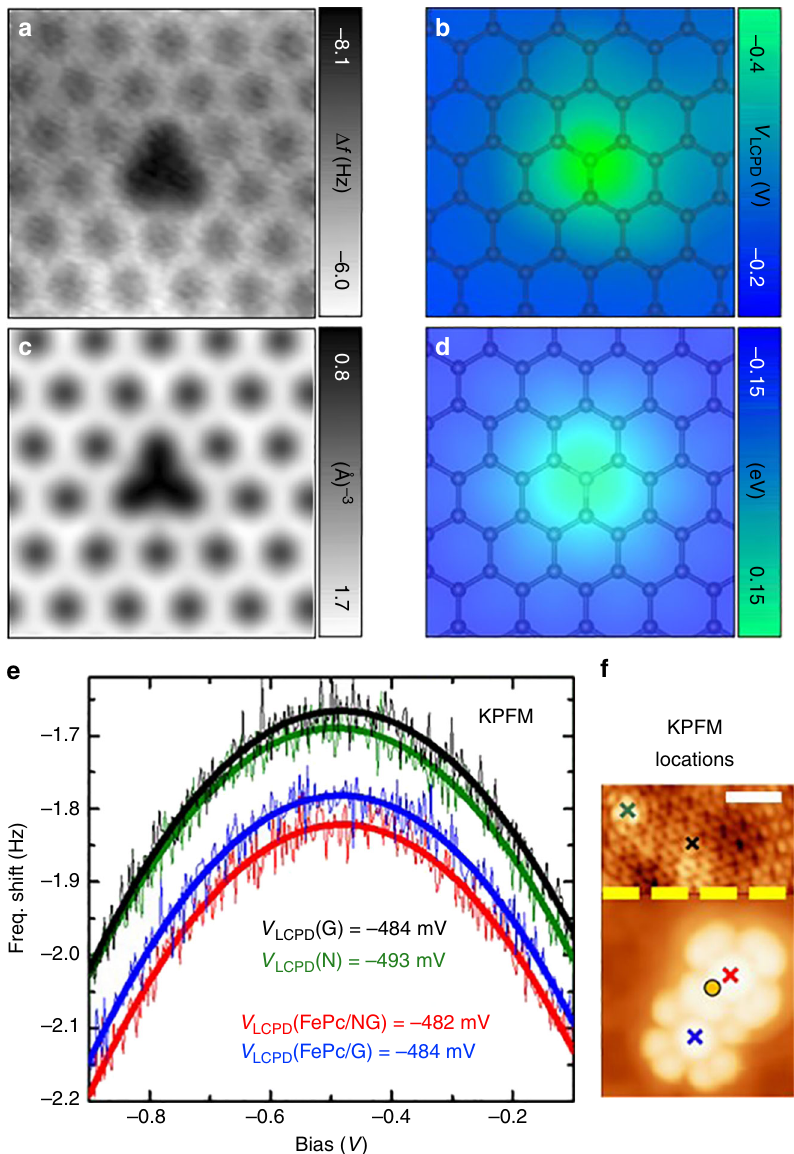
Fig. 3 Charge distribution in the N-dopant. a Atomically resolved constant-height AFM image of a single N-dopant in graphene. b Local contact potential difference ( V LCPD ) map acquired at a constant height immediately after (A) over the same area but with the tip retracted by 200 pm. c Calculated total electron density of N-doped graphene. d Calculated Hartree potential of a single N-dopant in graphene. e Frequency shift dependence with bias voltage acquired at the center of a FePc molecule adsorbed on pristine graphene (blue) and at an N-dopant (red), as well as on an N-dopant (green) and on a C atom in pristine graphene (black). The four measurements were acquired at the same tip-sample distance and errors in V LCPD fi ttings are about 1.5 mV. f STM image with the measurement locations, recorded at V b = ‒ 0.05 V (top part) and ‒ 2.0 V (bottom part). The orange circle marks the position of the N-dopant beneath the FePc molecule determined from the LCPD measurements. The scale bar corresponds to 1 nm. The data plotted in ( b ) and ( e ) were acquired in different sessions with metallic tips at different tip-sample